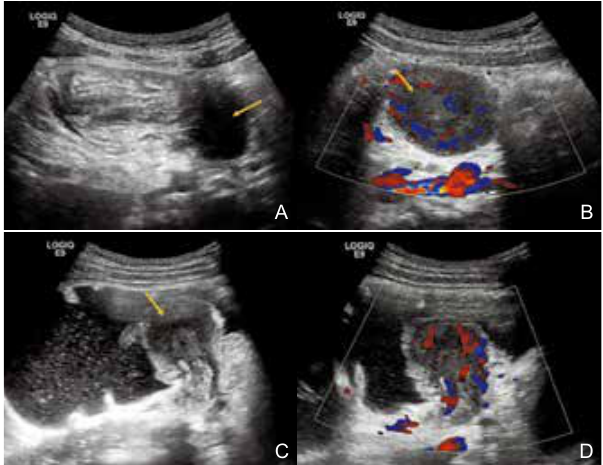
Figure 5 The ultrasonic examination of a girl (age: 3 months) showing intussusception secondary to intestinal duplication which was confirmed by surgery. (A) The long axis showing the “sleeve sign”. Ultrasonography revealed cystic masses (arrow) at the neck of the intussusception with walls showing an intestinal wall-like structure; (B) CDFI revealed dot-like blood flow signals at the wall of the cystic mass.